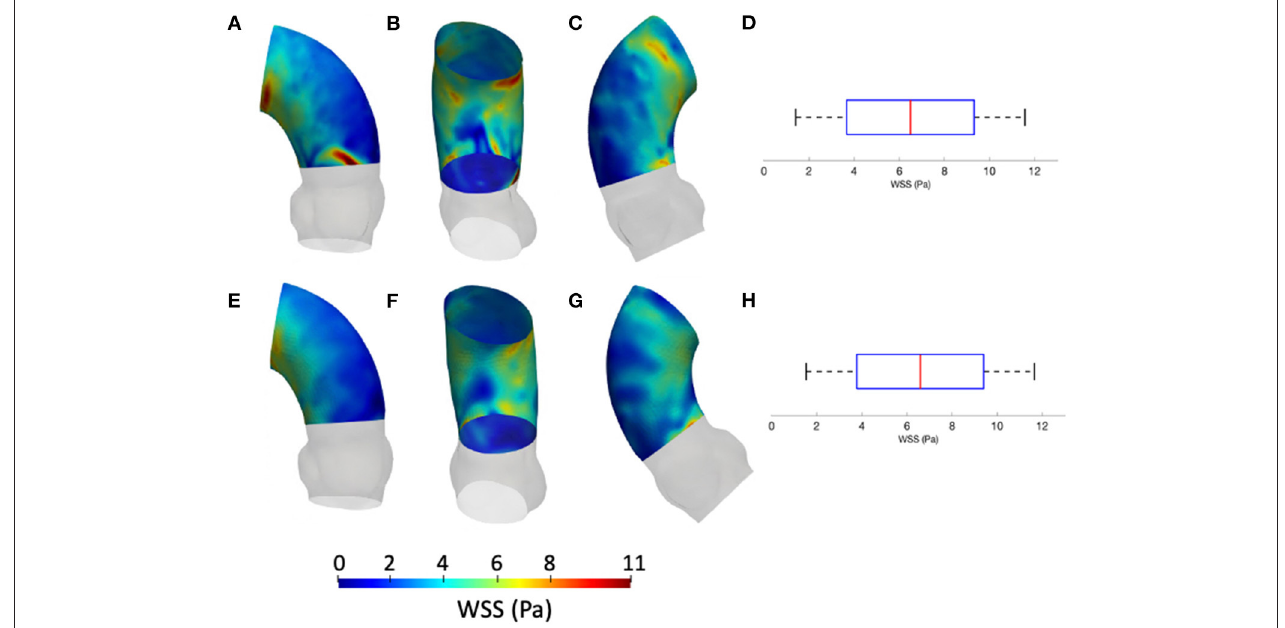
FIGURE 9 | Contour map of the WSS for CFD RBF [min: 1.1 Pa, avg: 6.6 Pa, max: 11.5 Pa] (A–C) and FSI [min: 1.3 Pa, avg: 6.5 Pa, max: 11.6 Pa] (E–G) simulations. Box plots of the WSS are reported for CFD RBF (D) and FSI (H)